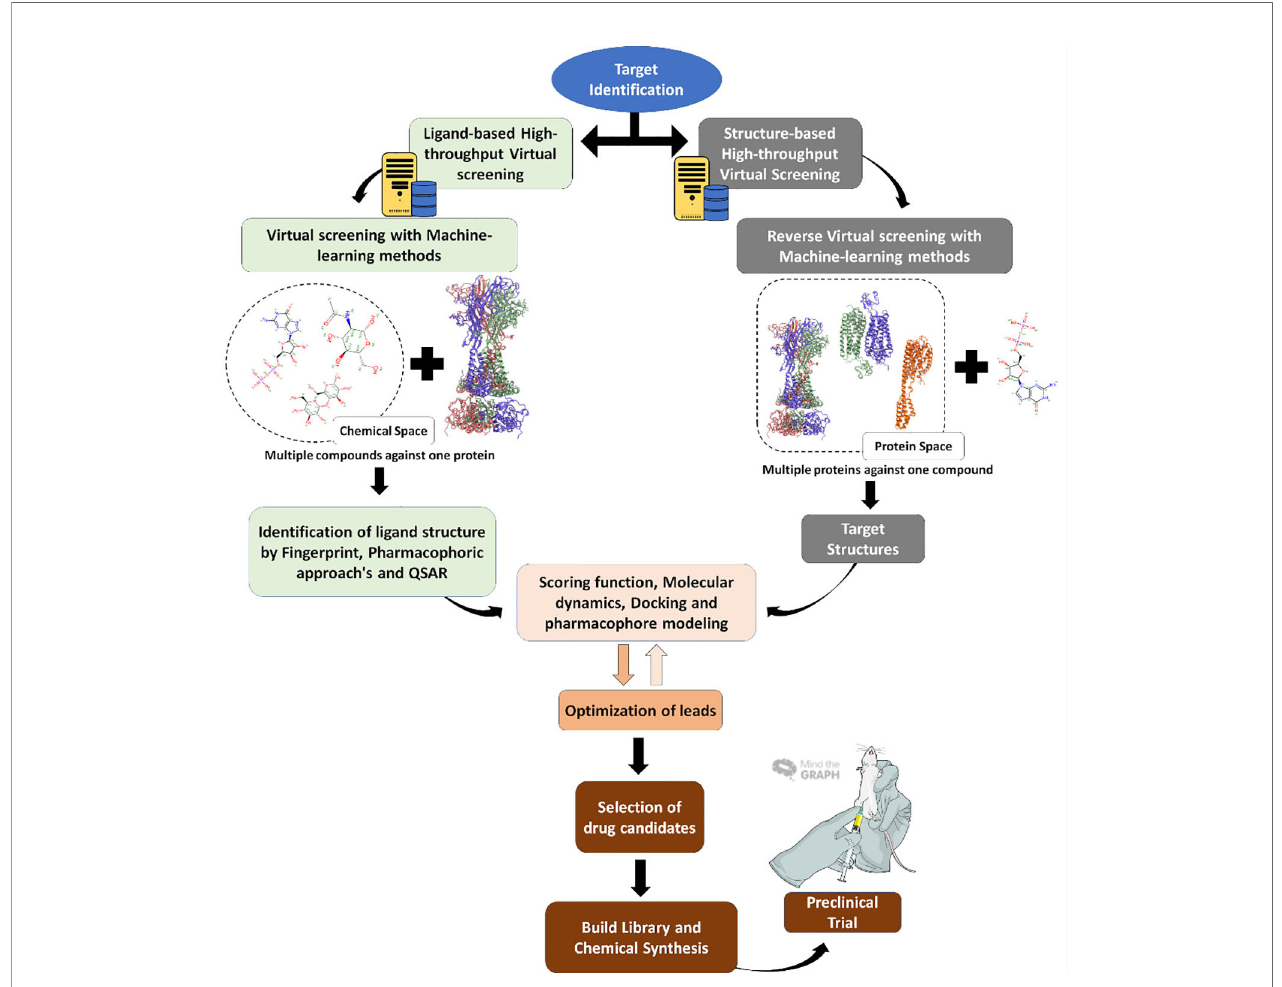
FIGURE 3 | Virtual screening work fl ow. Virtual screening steps since target identi fi cation, usually a protein (right) or the reverse, with the target being the molecule, until the fi nal step of in vitro and in vivo